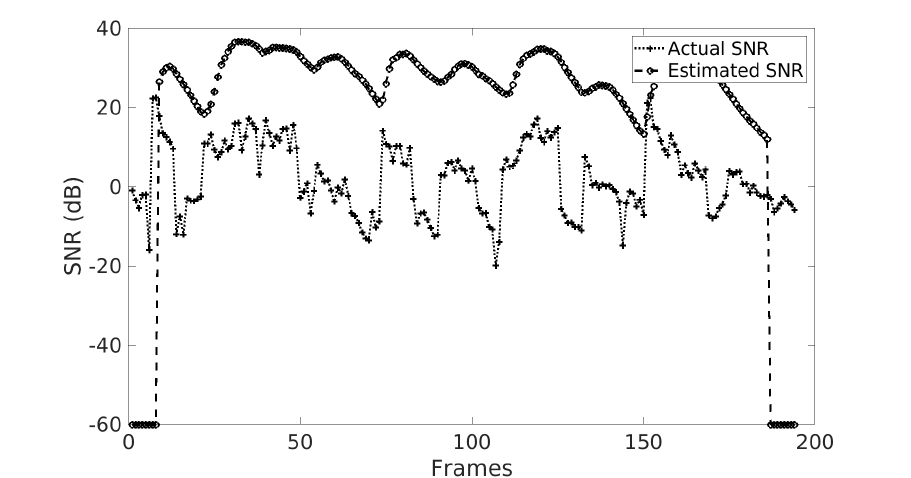
Figure 2. Comparisons of actual SNR with estimated